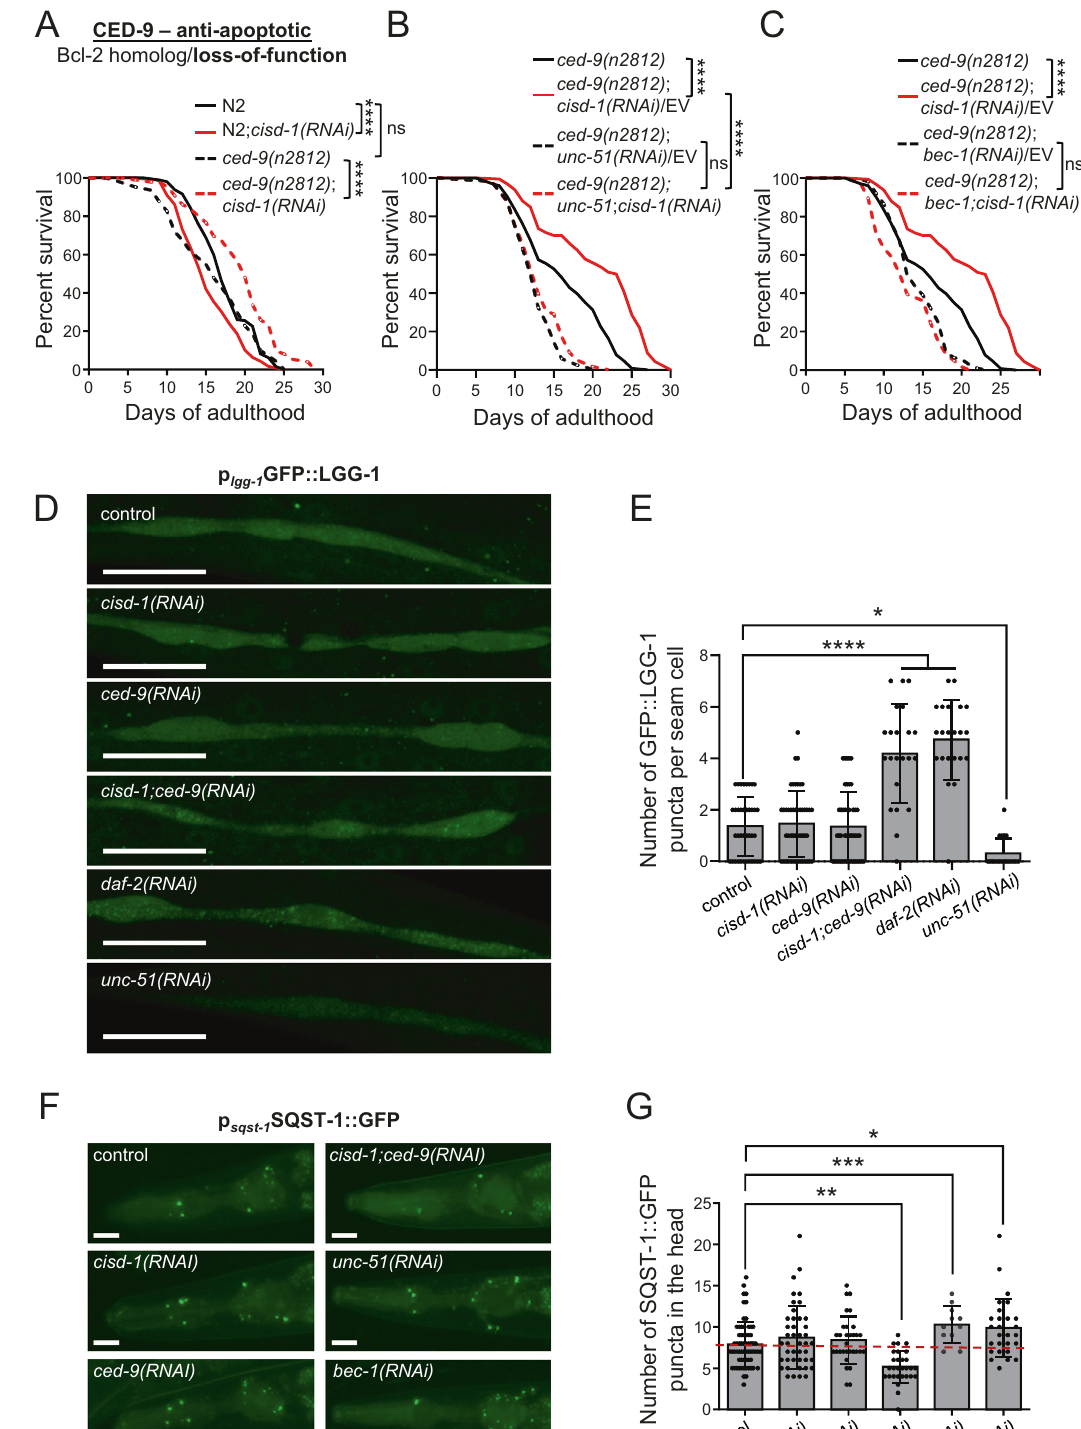
fi ndings indicate that induction of autophagy mediates lifespan extension upon depletion of both CISD-1 and CED-9. To further corroborate this notion, we monitored autophagy induction and autophagic fl ux, in vivo, by using the DA2123 [p lgg-1 GFP::LGG-1] and the HZ589 [p sqst-1 SQST-1::GFP]